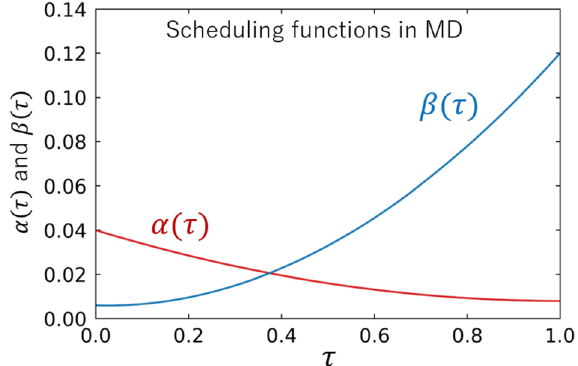
Figure 2. The actual scheduling functions in our MD run. See “Methods” section for their analytic forms.